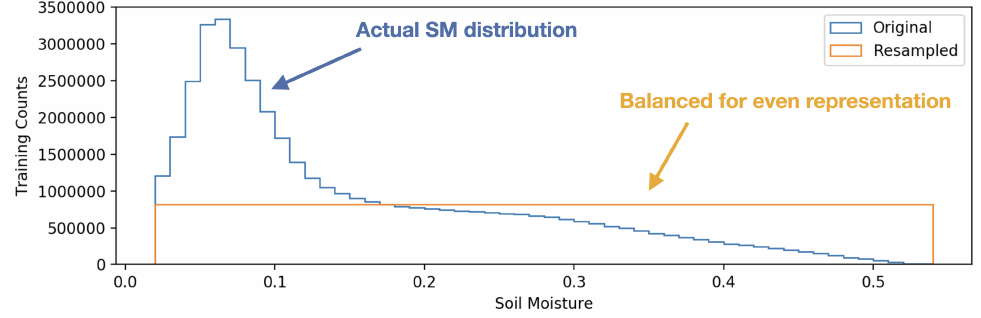
Figure 5. The original target distribution in blue compared to the balanced in